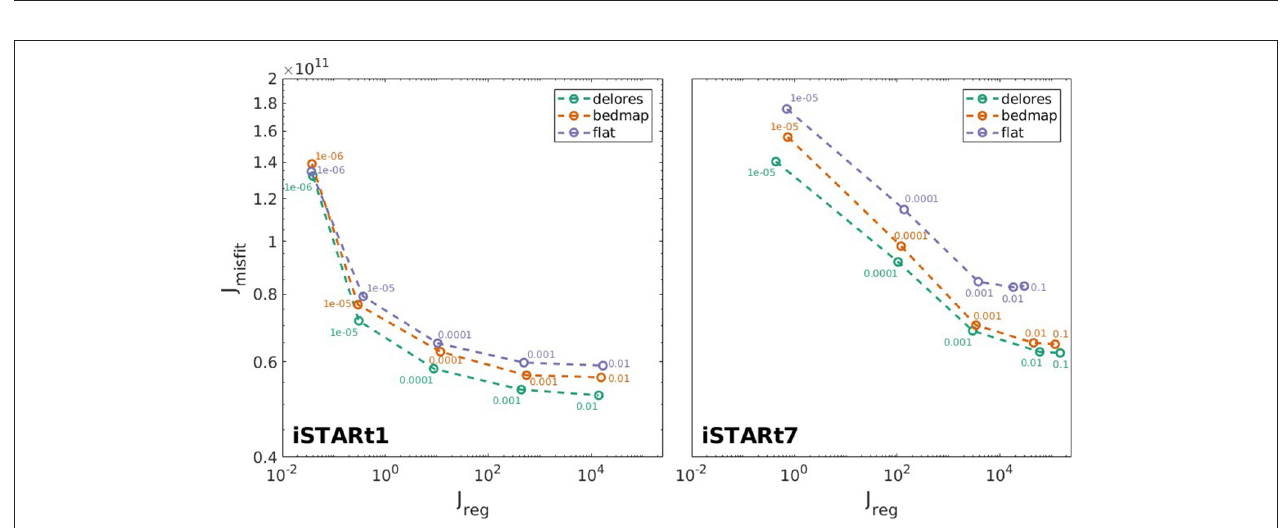
FIGURE 5 | The basal stress field from inversion of surface data over 100km 2 of PIG. The result in the top row shows the fields from inversion with BEDMAP2 topography, and in the second row the results are using a smoothed out topography. Mean basal shear stress for each is given.